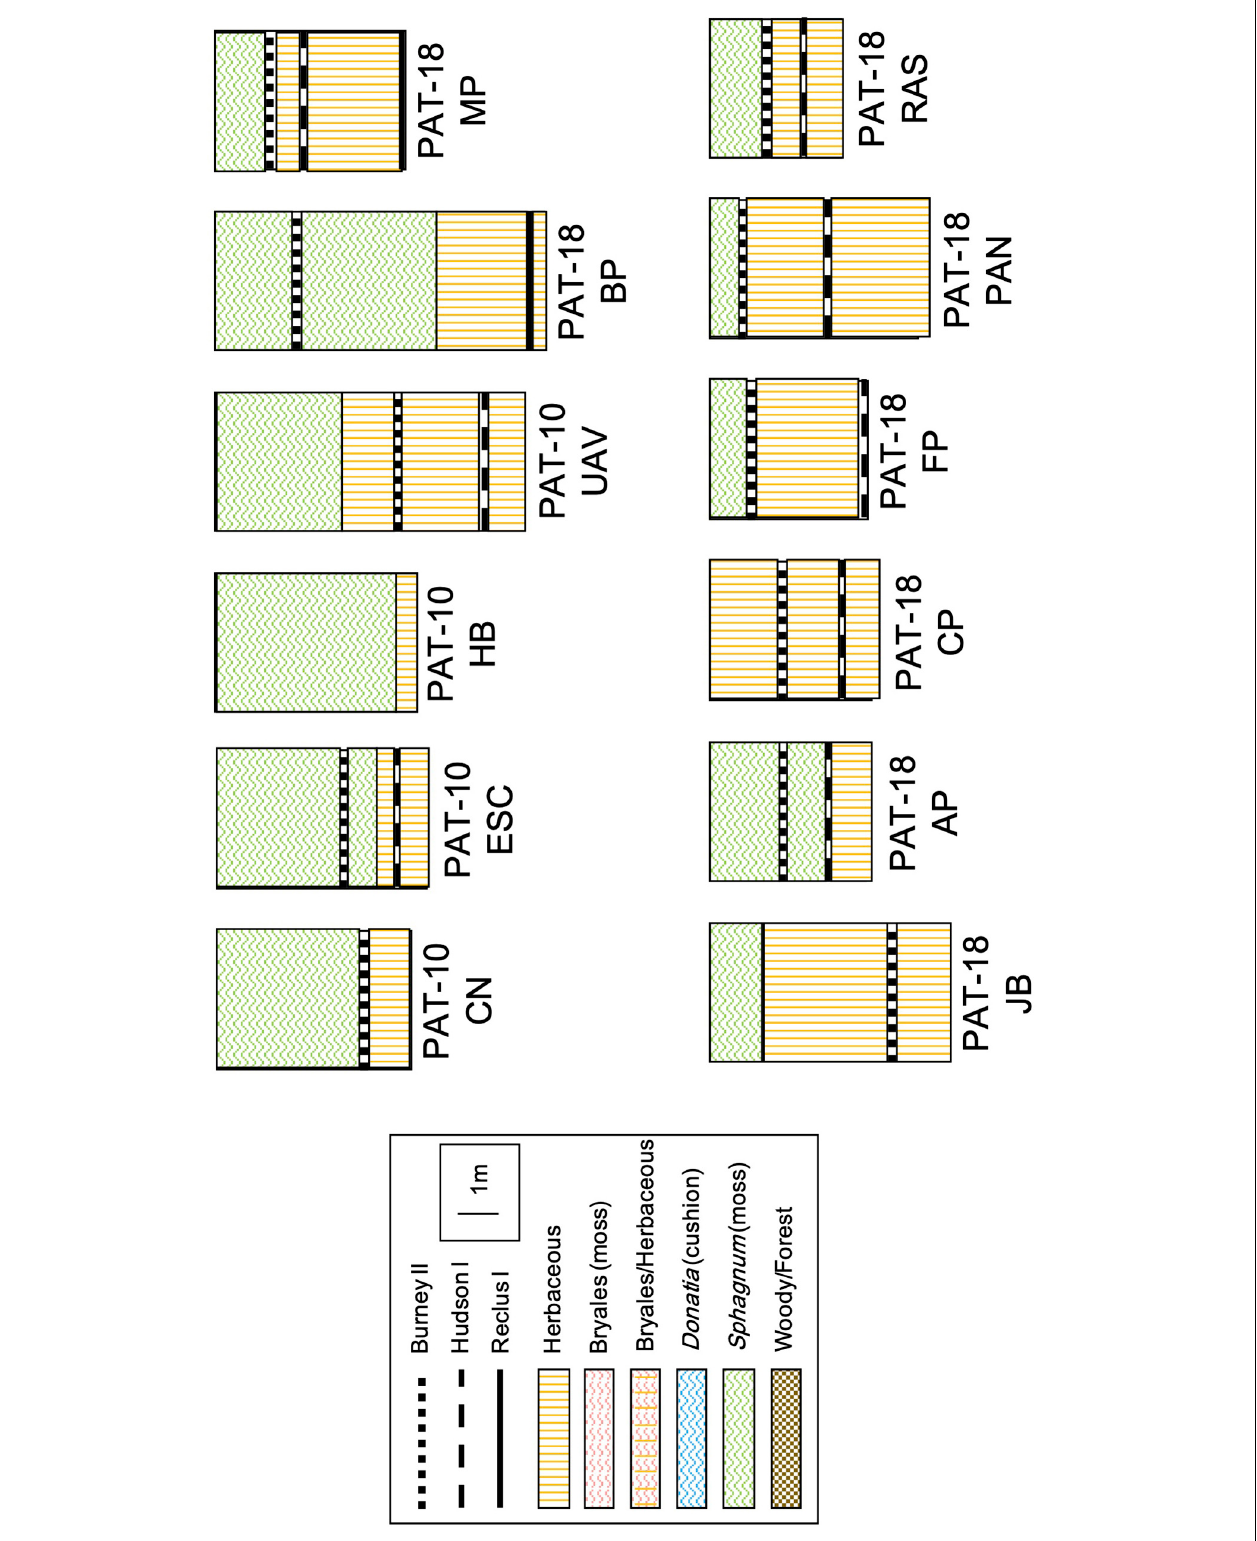
FIGURE 3 | Peat stratigraphic profiles for the 12 new sites included in this study. The sketches are true to scale. The remaining 78 peat profiles from the literature review can be found in the Supplementary Information ( Supplementary Figure S4 ).